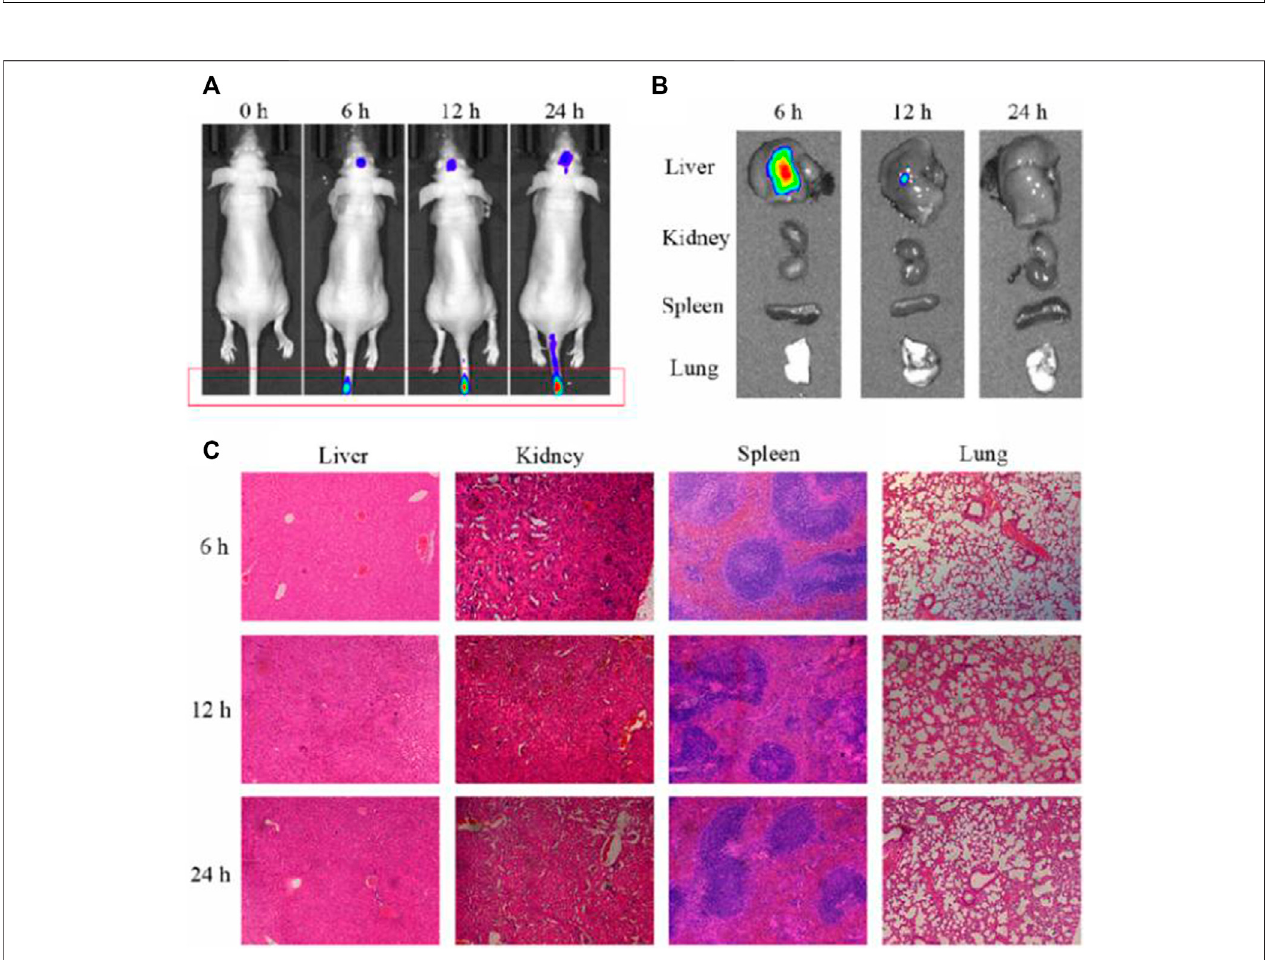
Frontiers in Molecular Biosciences |